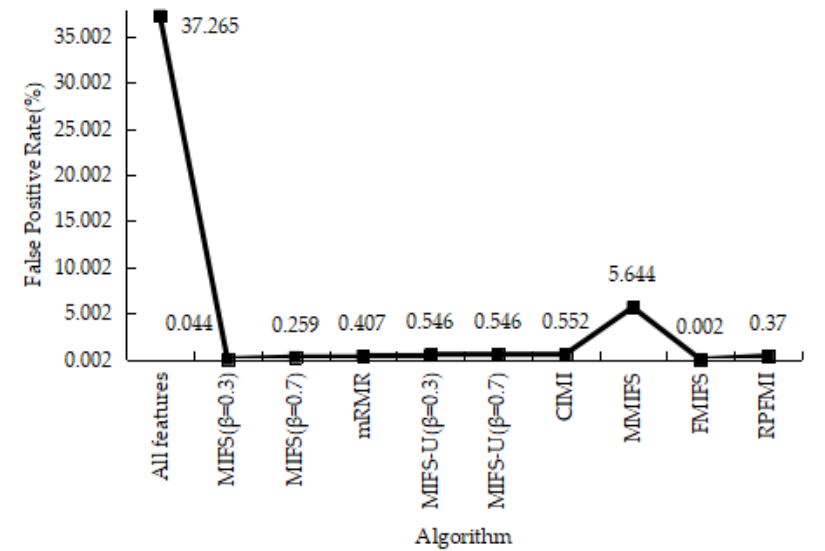
Figure 7. False Positive Rate on the U2R test data. Appl. Sci. 2018 , 8 , x FOR PEER REVIEW